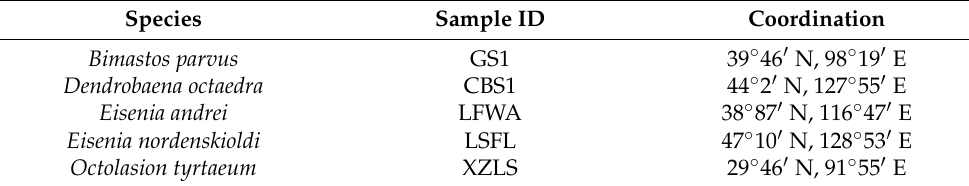
Table 1. Locations of the samples collected. Species Sample ID Coordination Bimastos parvus GS1 39 ◦ 46 (cid:48) N, 98 ◦ 19 (cid:48) E Dendrobaena octaedra